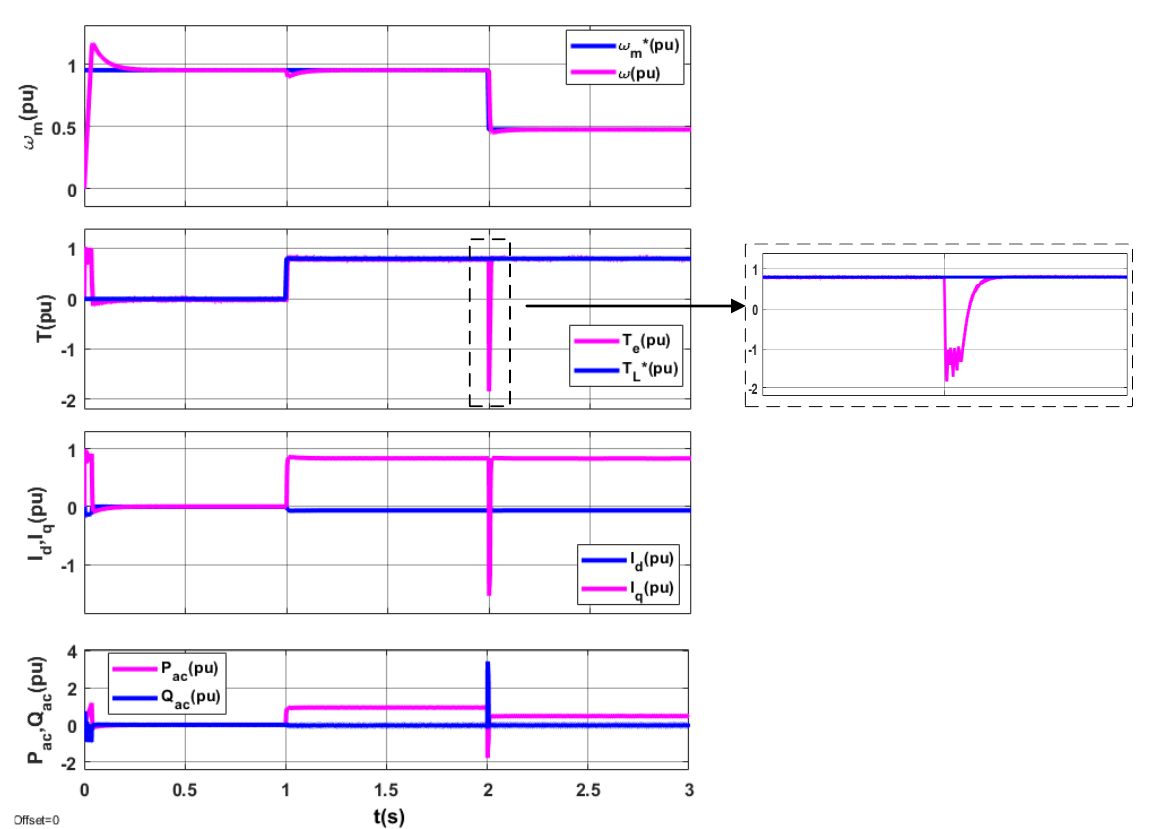
Figure 8. Energy processes (Pac, Qac) in the inverter-PMSM propulsion system during changes in speed and torque with energy optimization.